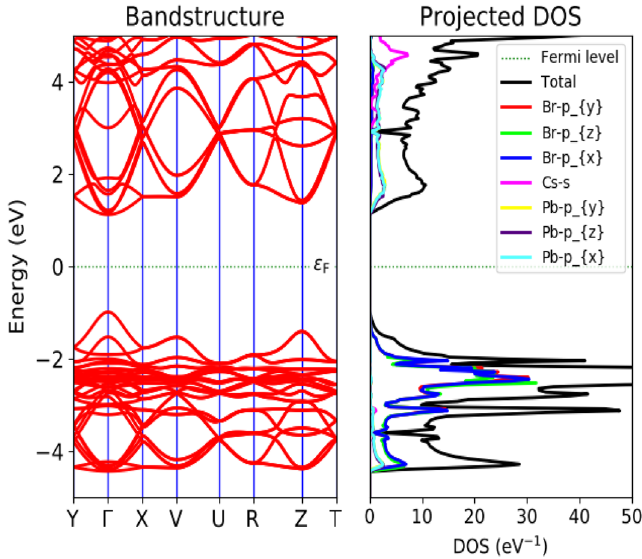
Figure 3. Band structure and density of states (DOS) of bulk orthorhombic CsPbBr 3 calculated from DFT-1/2.